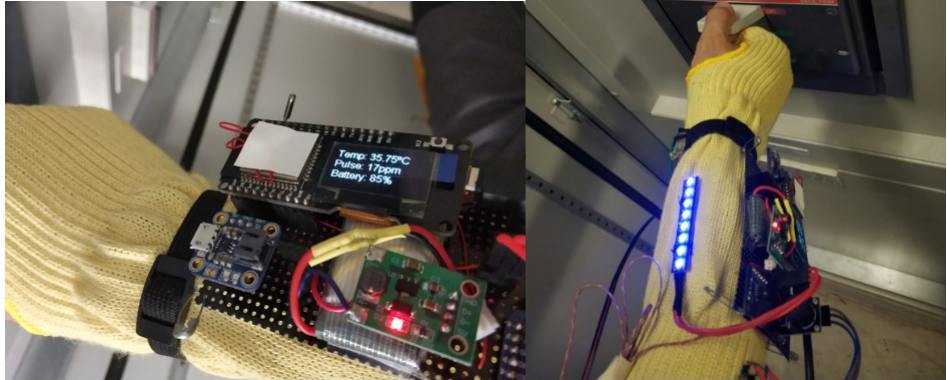
Figure 9. Picture of the data displayed on the screen and of the active pulse alarm.